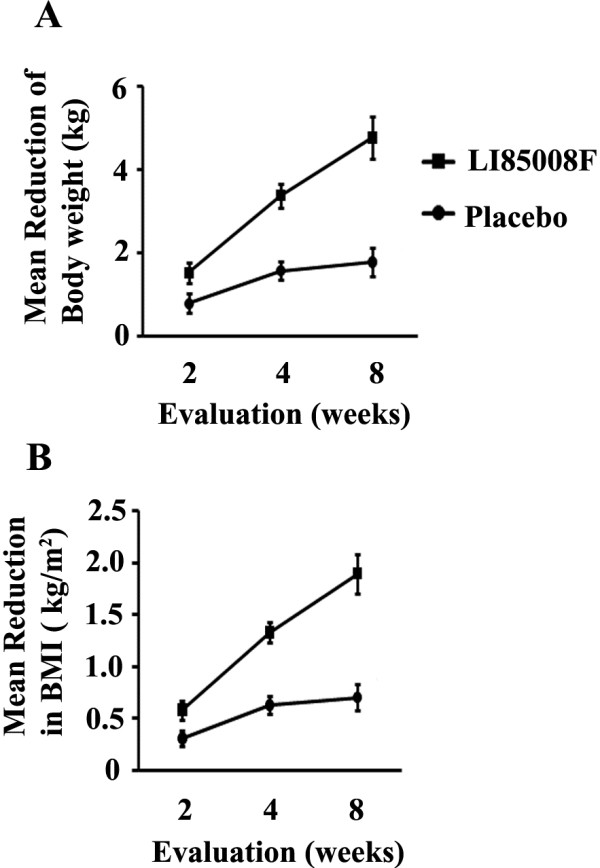
LI85008F reduces changes in body weight and Body Mass Index in obese subjects. Line diagrams represent mean reduction in body weight (A) and Body Mass Index (B) from baseline to 8 weeks in placebo (n = 20) and LI85008F (n = 21) supplemented groups, respectively. Values represent mean ± SE.